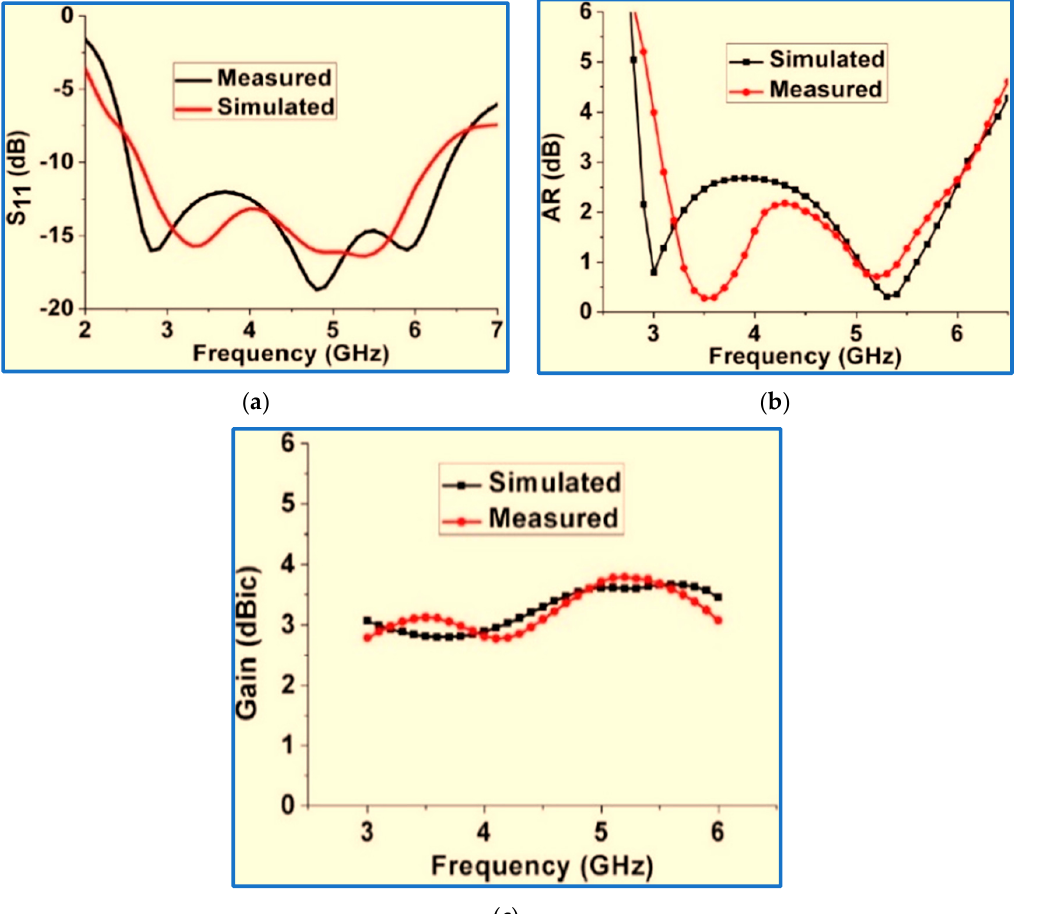
Figure 30. Comparison results for the asymmetric-fed rectangular monopole antenna: ( a ) S11 results; ( b ) AR results; ( c ) antenna CP gain [142].